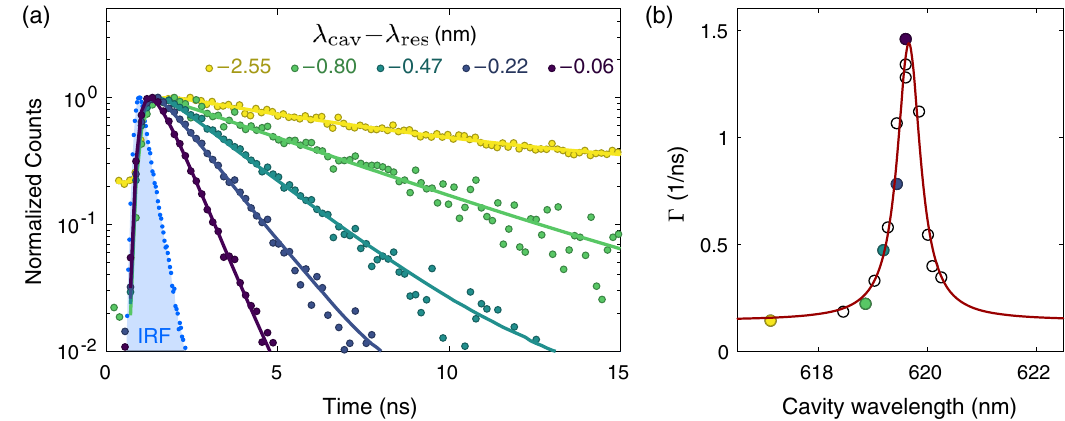
FIG. 3. Time-resolved PL measurements. (a) Representative lifetime measurements at different cavity wavelengths. To fit the data we convolve a single-exponential decay with the instrument response function (IRF) of our detectors (blue). (b) PL recombination rates of the studied SnV − center plotted as a function of cavity resonance wavelength [ Γ ð λ Lorentzian model (red curve) to quantify the enhancement provided by the cavity. Filled circles correspond to lifetime data of the same color shown in